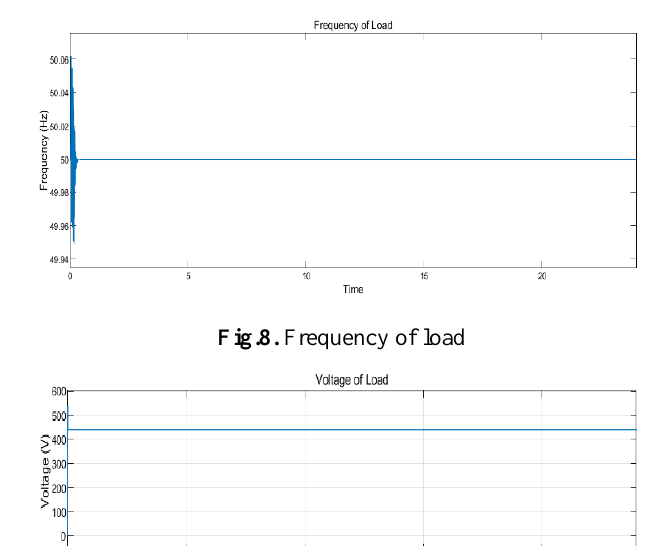
Fig. 4. Real output power of wind with reference